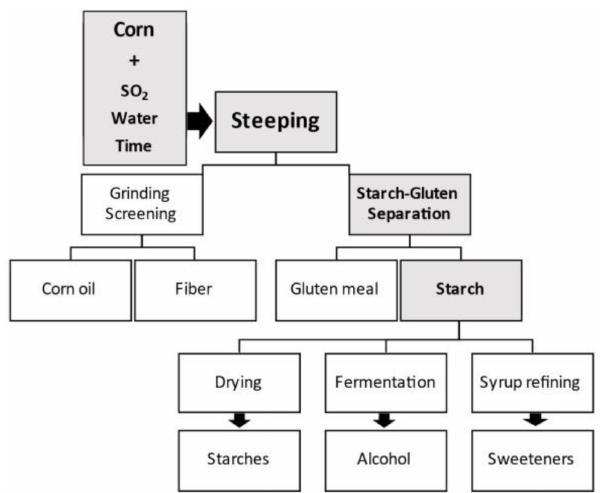
Figure 3. Diagram for corn wet-milling process flow to extract corn starch and output